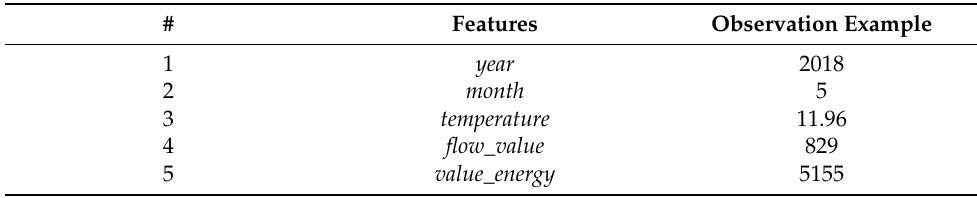
Table 4. Features present in the final